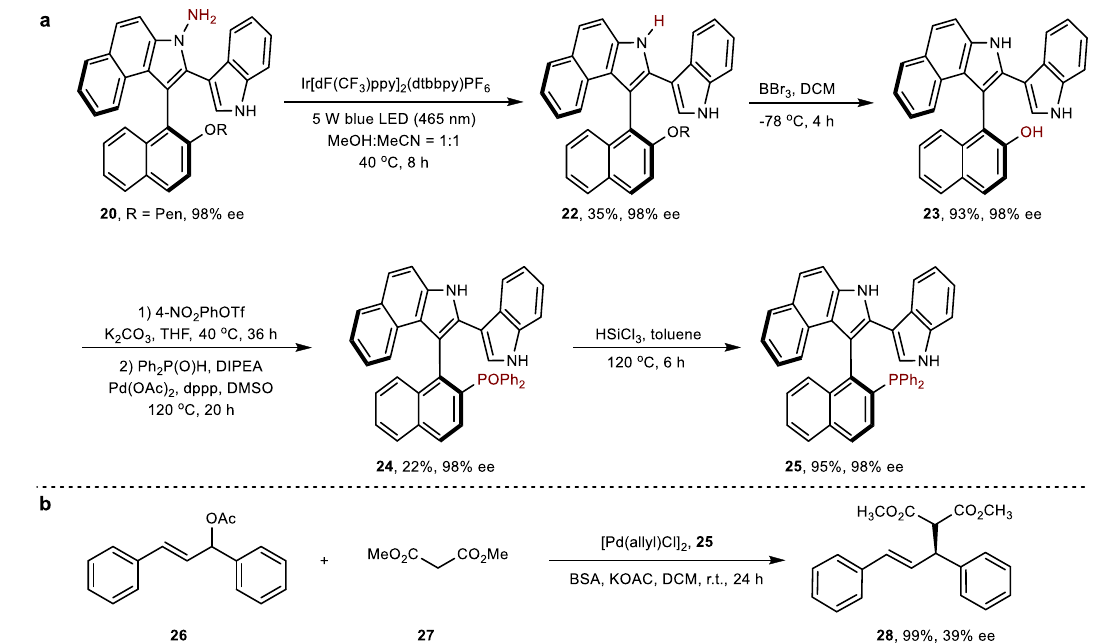
Fig. 5 Synthesis and application of chiral phosphine ligand. a Synthesis of chiral phosphine ligand 25 . b Asymmetric allylation using 25 as the